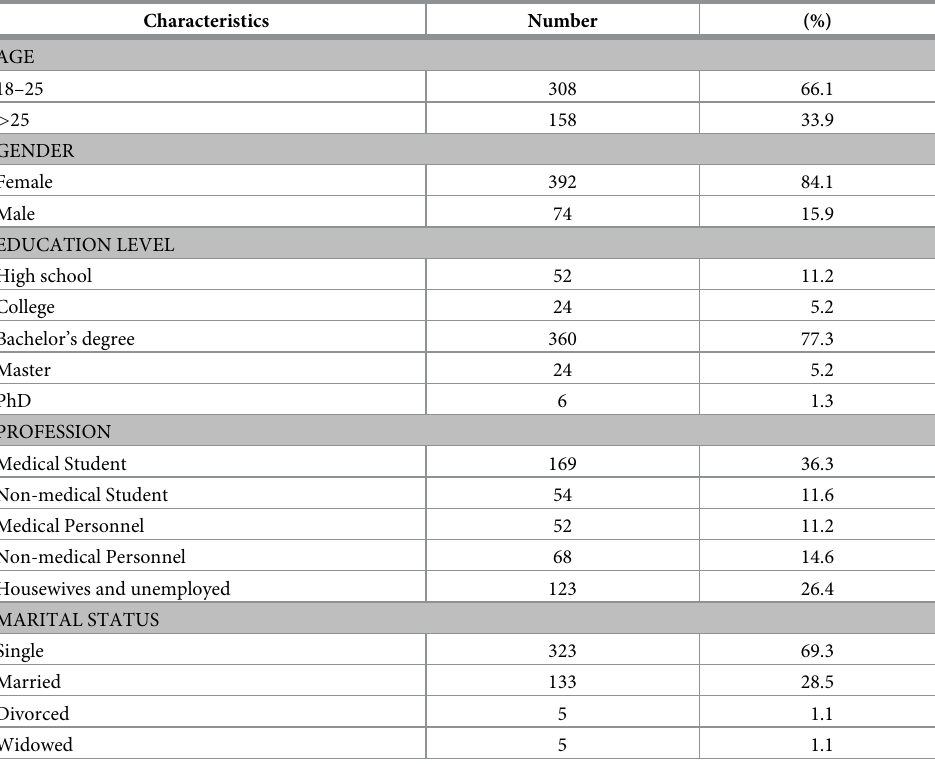
Table 2. Demographic characteristics of the participants in Jordan (n =